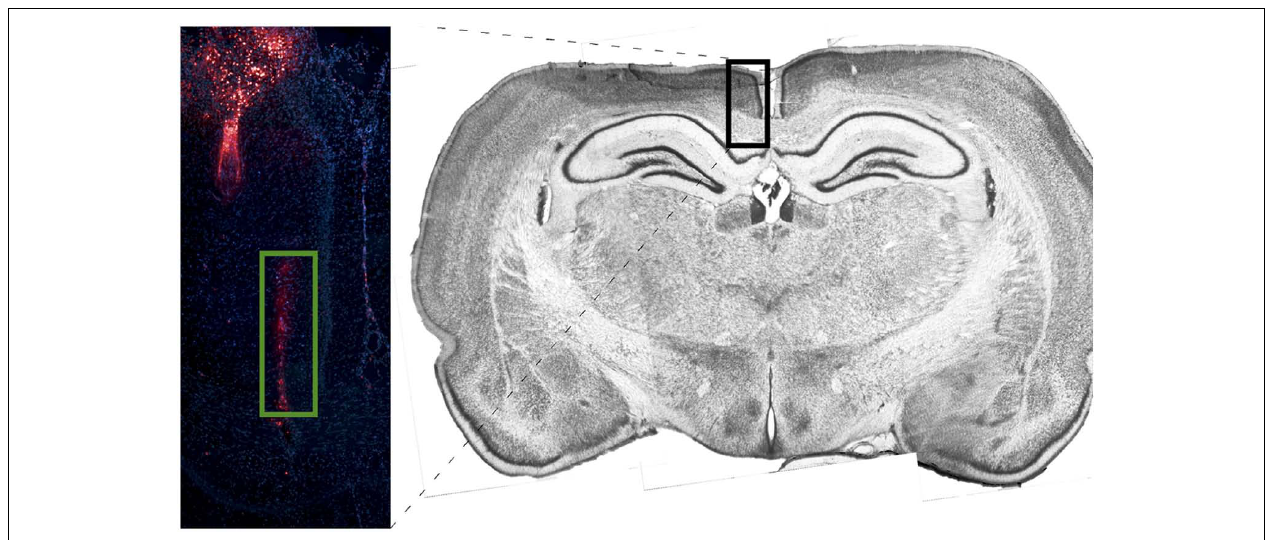
FIGURE 4 | Image depicting probe placement for one corpus callosum animal. Electrodes were coated with DiI and brain slices were stained using DAPI. One probe is shown to the left of midline with its lowest point in the